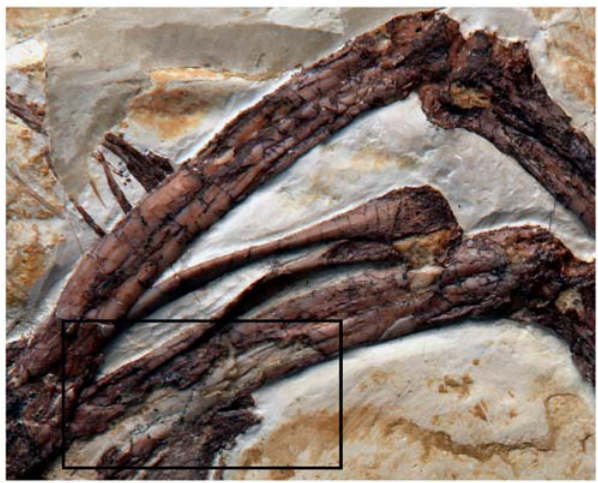
Figure 2. Skeletal elements from the largest known Archaeop- teryx specimen showing cortical delamination. Femora, tibiae, fibulae, pubes, and gastralia from the Solnhofen specimen (BMMS 500), are shown. The brown cortical layer of the left femur (inset box) is superior to the light gray underlying bone layer that is exposed where the former flaked-off. This is consistent with a growth line interface. These thin, hypermineralized osseous layers partition the more fibrous zonal tissues and act as planes of weakness where exfoliation can occur.